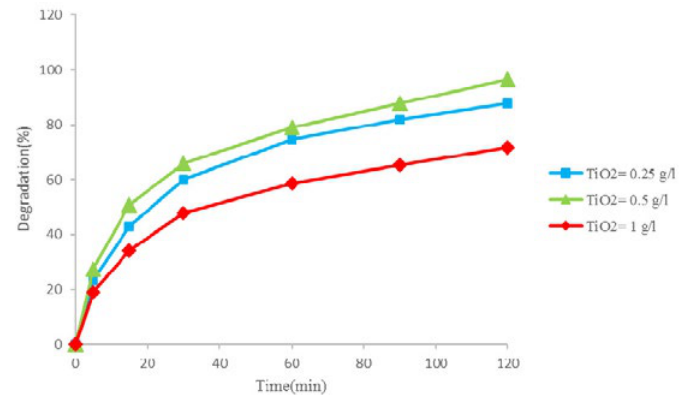
Fig. 5. Effects of Clindamycin concentration on photocatalytic Fig. 5 Effects of Clindamycin concentration on photocatalytic degradation